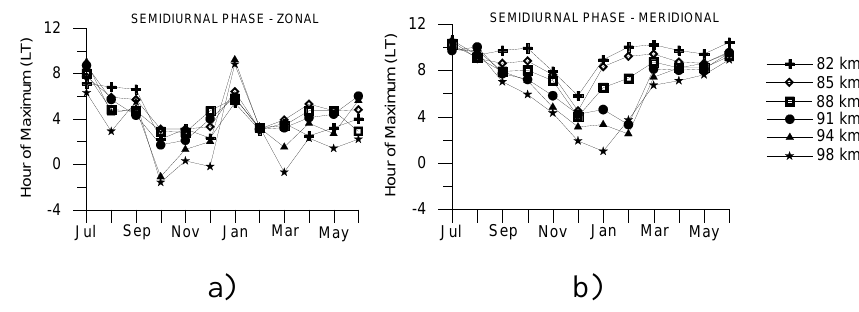
Fig. 10. Hour of maximum (phase) for zonal (a) and meridional (b) semidiurnal oscillations from July 2004 to June 2005.